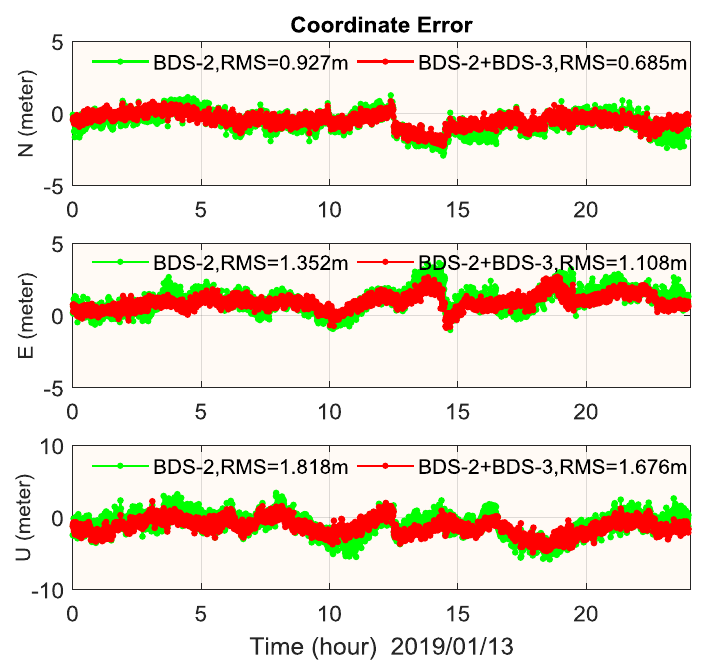
Figure 9. SPP comparison of BDS-2 only (green) and BDS-2 + BDS-3 (red) at station SGOC in North (upper), East (middle) and Up (lower) component.